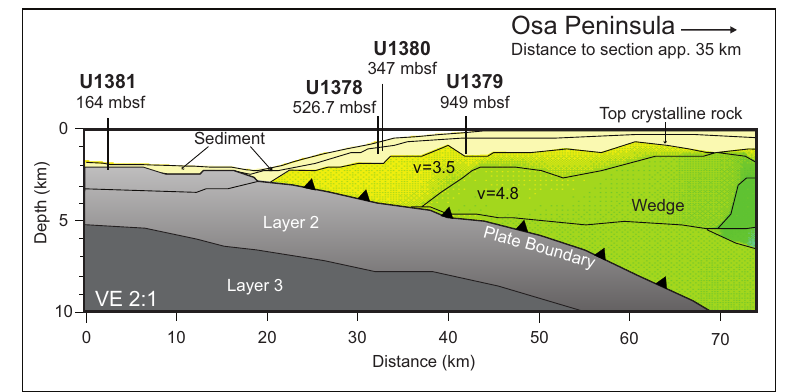
Figure 2. Interpreted wide-angle seismic section from Stavenhagen et al. (1998). Schematic figure through the Osa Peninsula margin showing Sites U1381, U1378, U1380, and U1379. VE=vertical exaggeration, v=P-wave velocity (km s -1